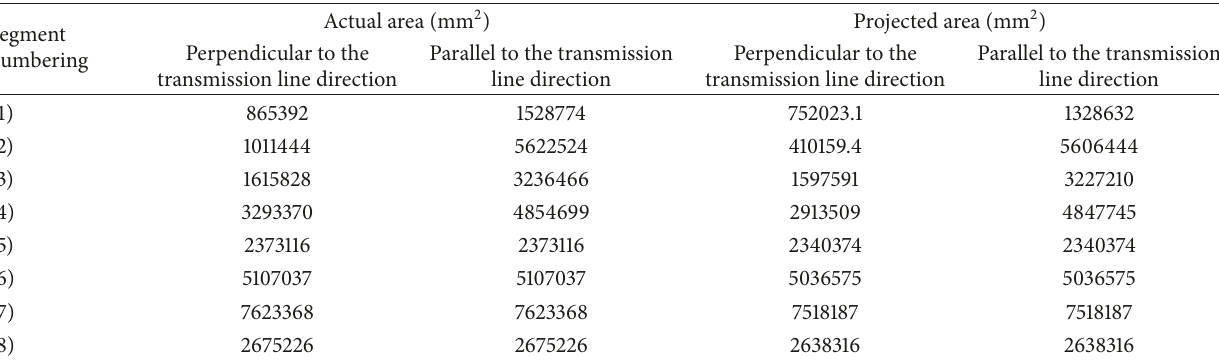
Table 5: Windward area of number 160 transmission